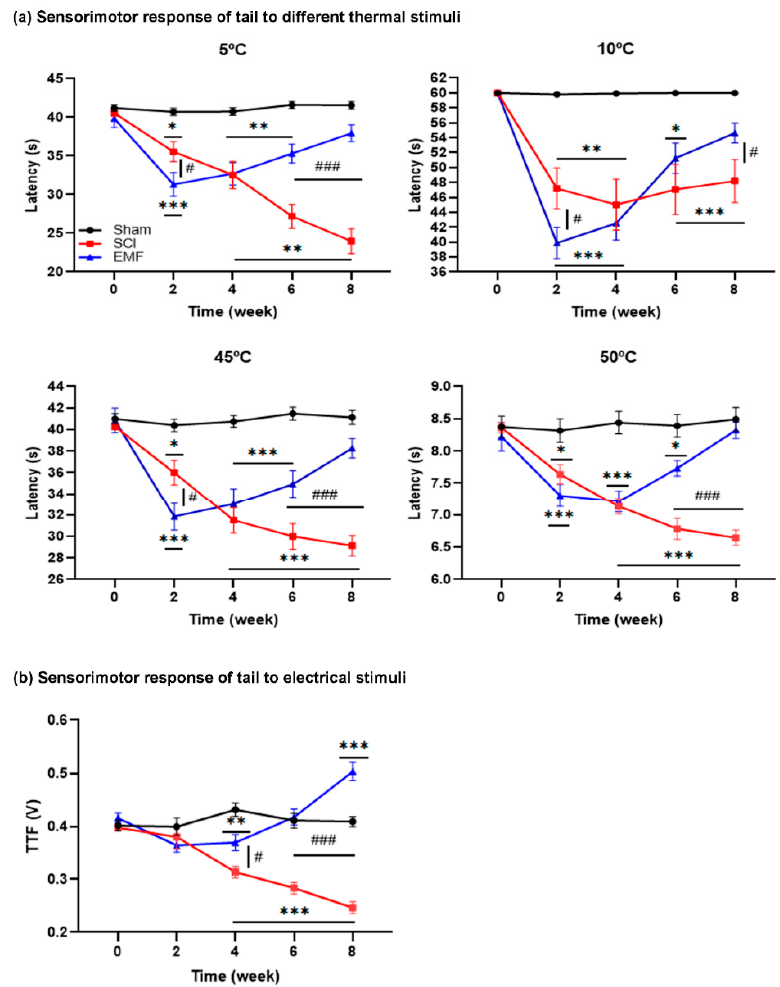
Figure 2. Effect of EMF stimulation on nociceptive responses of the tail to thermal and electric stimuli in SCI rats. Tail flick latencies to different thermal stimuli ( a ) and electrical stimuli ( b ) in the Sham ( n = 15), SCI ( n = 12), and EMF ( n = 14) groups of rats. * indicates a comparison between Sham and SCI/EMF groups, while # indicates a comparison between SCI and EMF groups. */ # p < 0.05, ** p < 0.01, and ***/ ### p < 0.001.